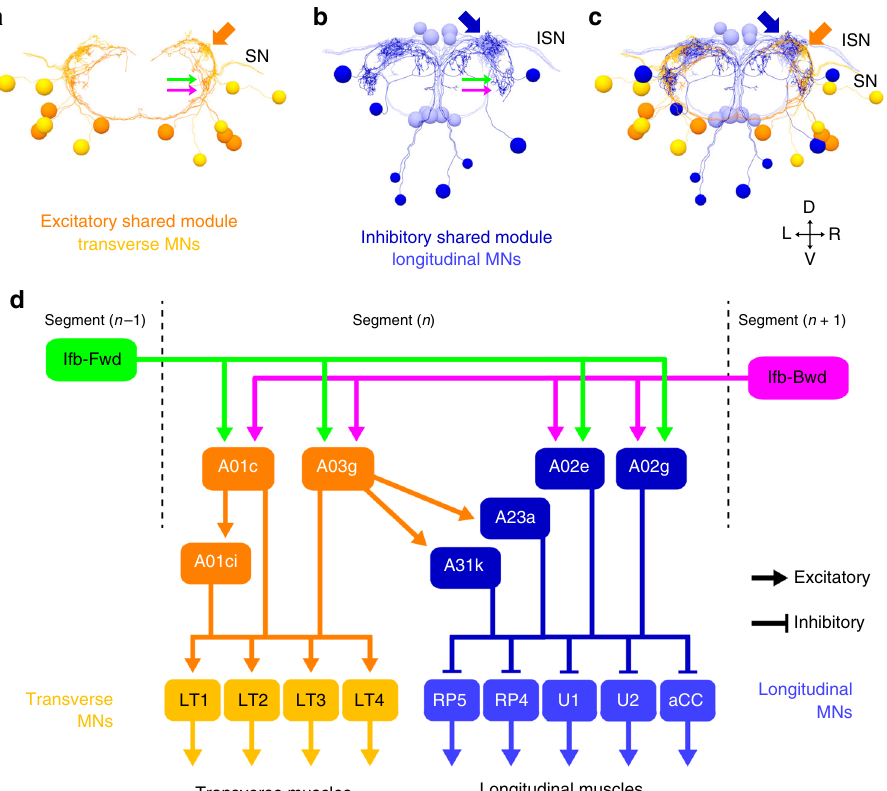
Fig. 5 The shared module neurons innervate MNs in a synergistic manner. a – c Posterior views of the connectivity between the shared module neurons and the target MNs. a Excitatory neurons in the module (dark orange) and the target transverse MNs (light orange). b Inhibitory neurons in the module (dark blue) and the target longitudinal MNs (light blue). c Merged image of ( a ) and ( b ). Arrows indicate the presynaptic sites of excitatory interneurons (dark orange), inhibitory interneurons (dark blue), and postsynaptic sites of the interneurons receiving inputs from Ifb neurons (green and magenta). SN: segmental nerve; ISN: intersegmental nerve. d Connectome of the shared module. Excitatory neurons in the module innervate MNs targeting transverse muscles. Meanwhile, inhibitory neurons in the module innervate MNs targeting longitudinal